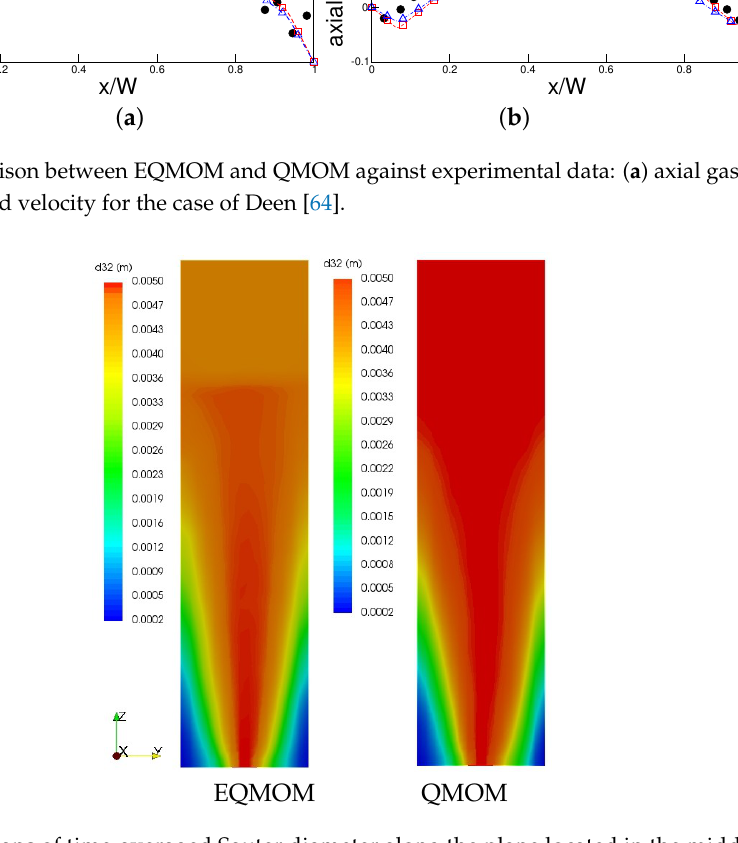
Figure 7. Color maps of time-averaged Sauter diameter along the plane located in the middle of the column of Deen